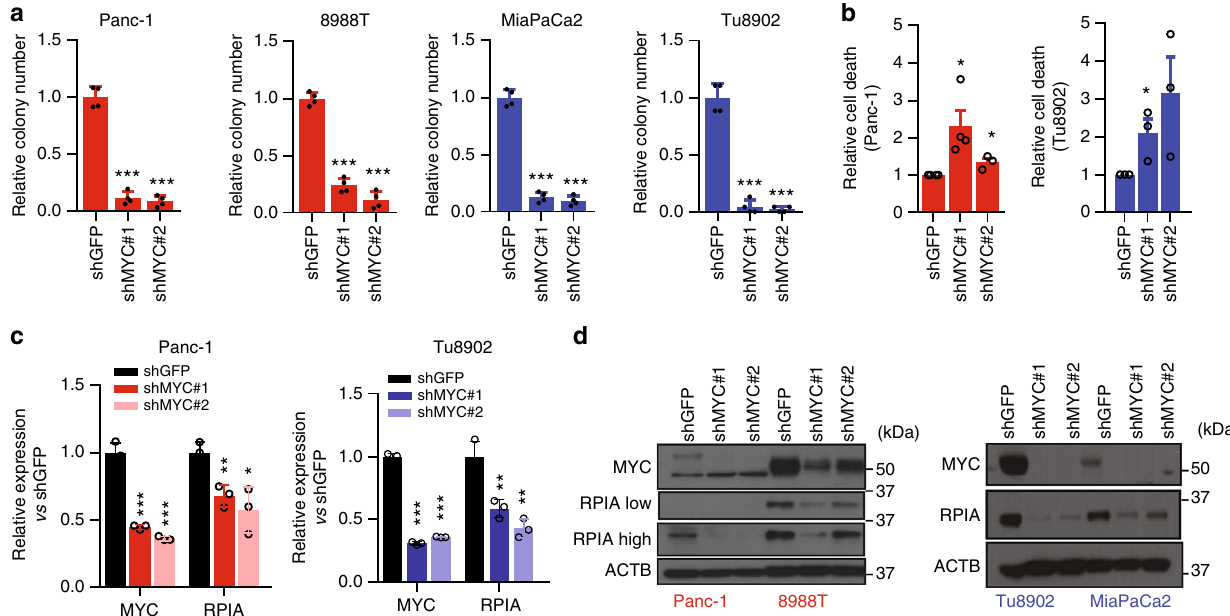
Fig. 4 MYC is required for survival of PDAC cells. a Clonogenic growth of PDAC cells expressing a control shRNA (shGFP) or two independent shRNAs targeting MYC. Error bars indicate s.d. of 2 technical replicates in 2 independent experiments. b Evaluation of cell death induction after MYC down- regulation using Annexin V-FITC and propidium iodide fl ow cytometry. Relative fold change in cell death of averaged experiments (error bars show s.e.m). c Relative mRNA levels of MYC and RPIA after MYC inhibition. Values are normalized to β -actin. Error bars represent s.d. of three technical replicates (1 representative of 3 experiments). d Immunoblot of PDAC cells expressing shGFP or shMYC shRNAs. For all panels, signi fi cance determined with t-test . * p < 0.05, ** p < 0.01, *** p < 0.001